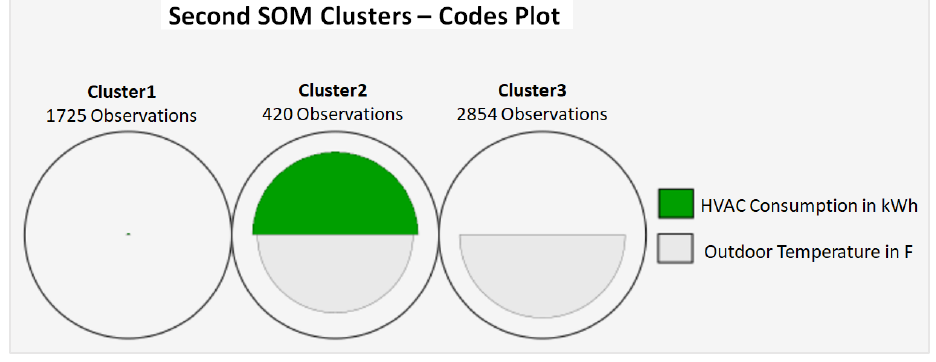
Figure 14. Second-time SOM-generated clusters.